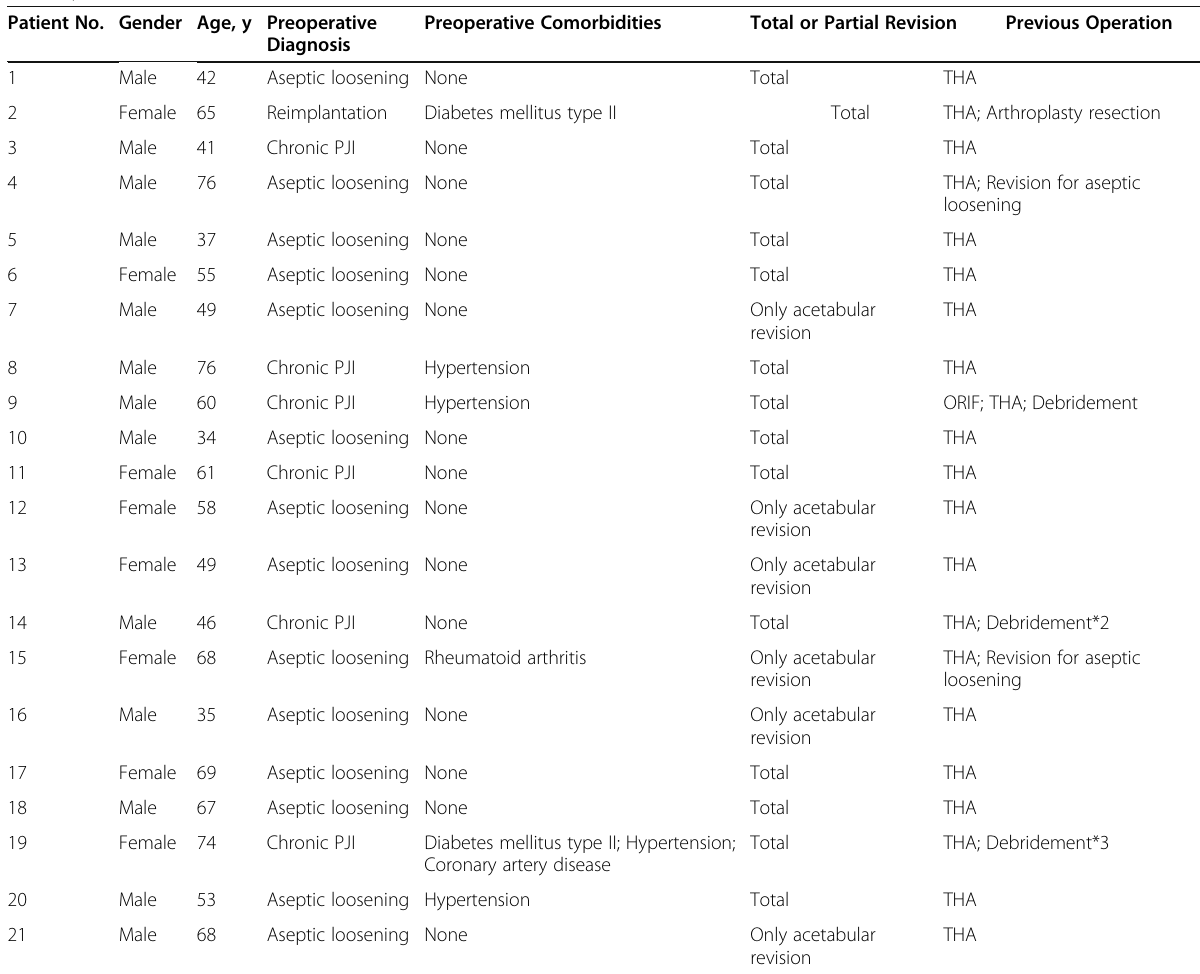
Table 1 Demographic factors for 21 episodes with severe protrusio acetabular defects treated by the multicup reconstitution technique Patient No. Gender Age, y Preoperative